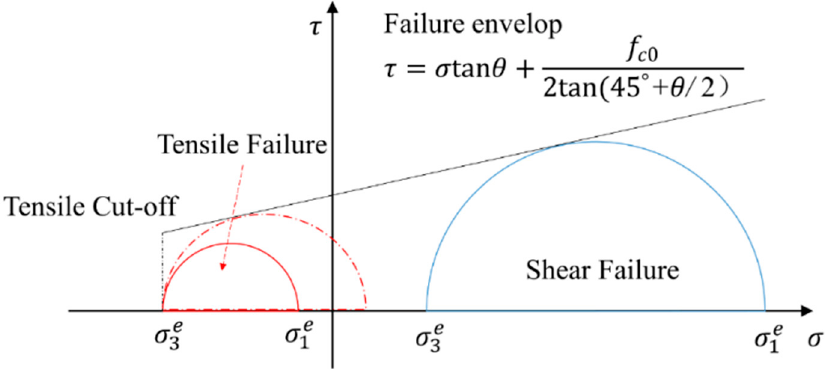
Figure 6. Maximum tensile stress criteria and the Coulomb shear failure criteria used in the model. The red and blue Mohr circles represent stress states where tensile failure and shear failure are imminent.